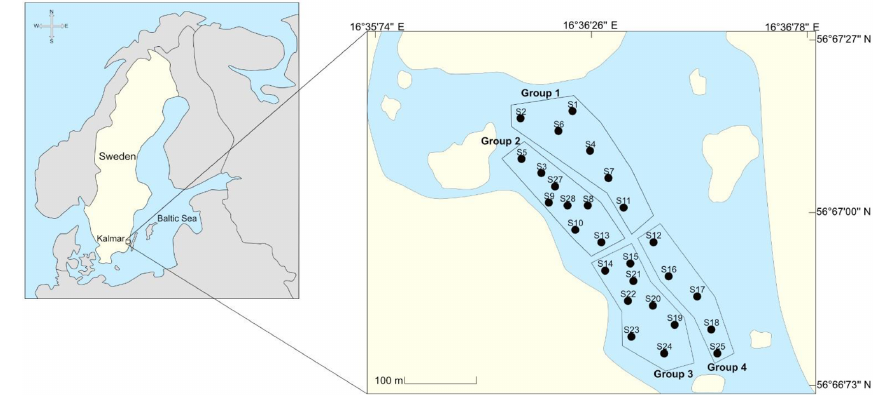
Figure 1. Location of the study area and sampling stations.